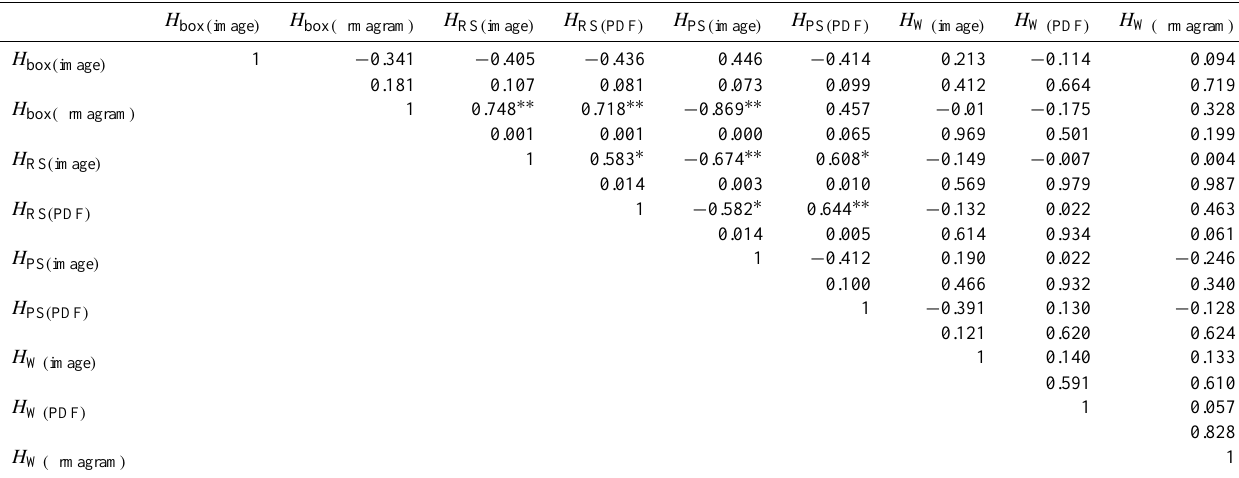
Table 7. Pearson-r correlation matrix for the Hurst exponents of four techniques applied: Box dimension, R / S analysis, Power spectrum and